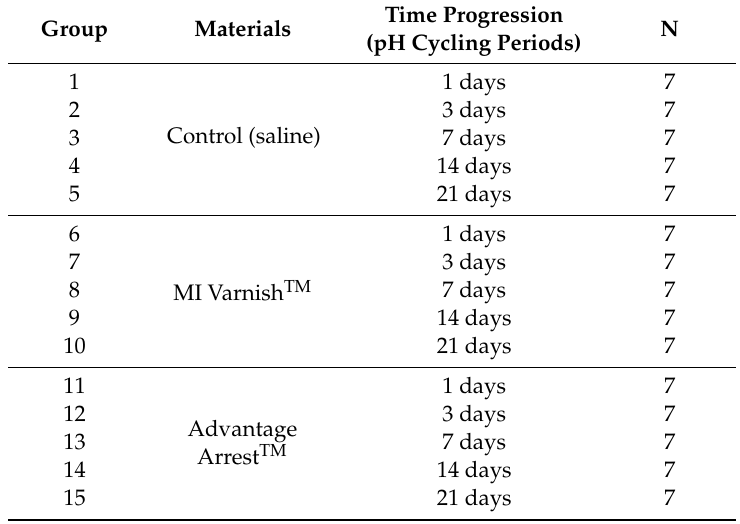
Group Table 2. Classification of the groups according to the materials and time progression. Group